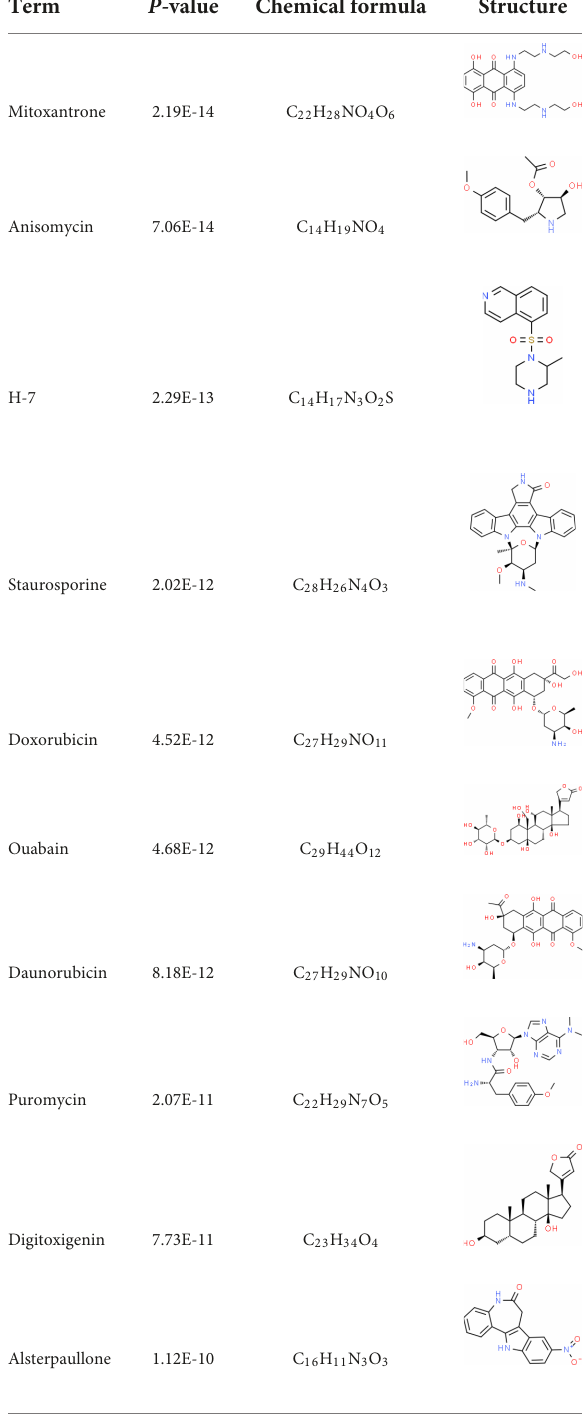
TABLE 2 List of the suggested drugs for